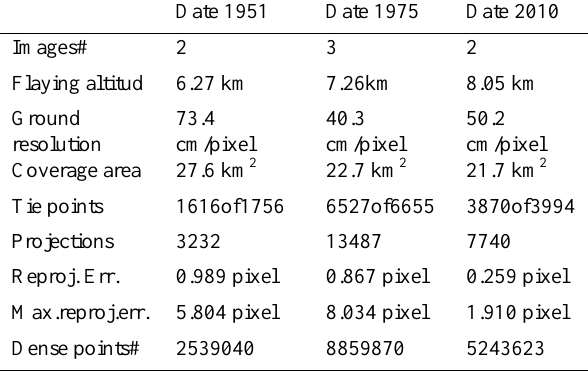
Table 2. Point cloud creation results